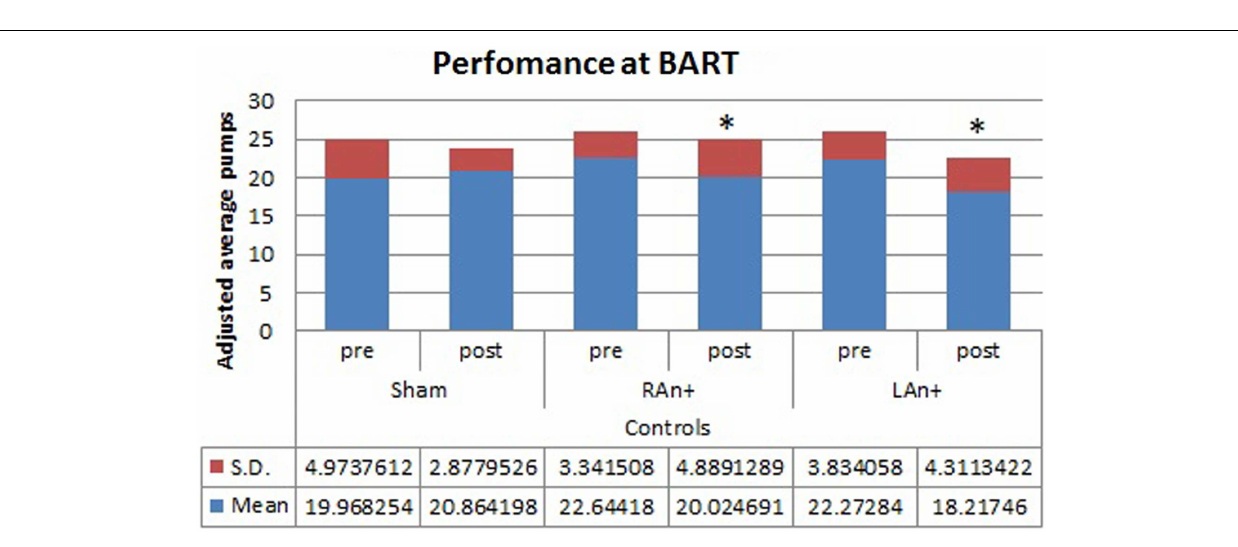
FIGURE 4 | Controls’ performance at the BART test .This figure represents the controls’ performance (adjusted average pumps) at the BART test before and after each stimulation (* p <